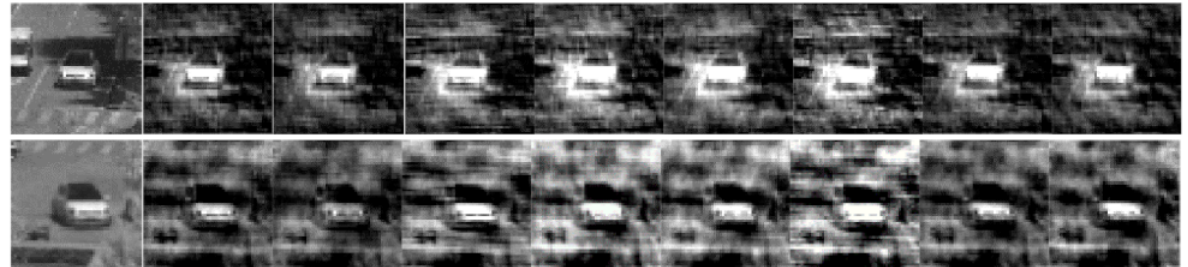
Figure 10. Visualization of the spatial-spectral feature maps extracted from different sub-HSIs. Activations are shown for two frames from the deformation challenging car sequences ( left ). The spatial-spectral features ( right ) are extracted on each sub-HSI. Notice that although the appearance of object changes significantly, we can still extract discriminative features even the background has changed